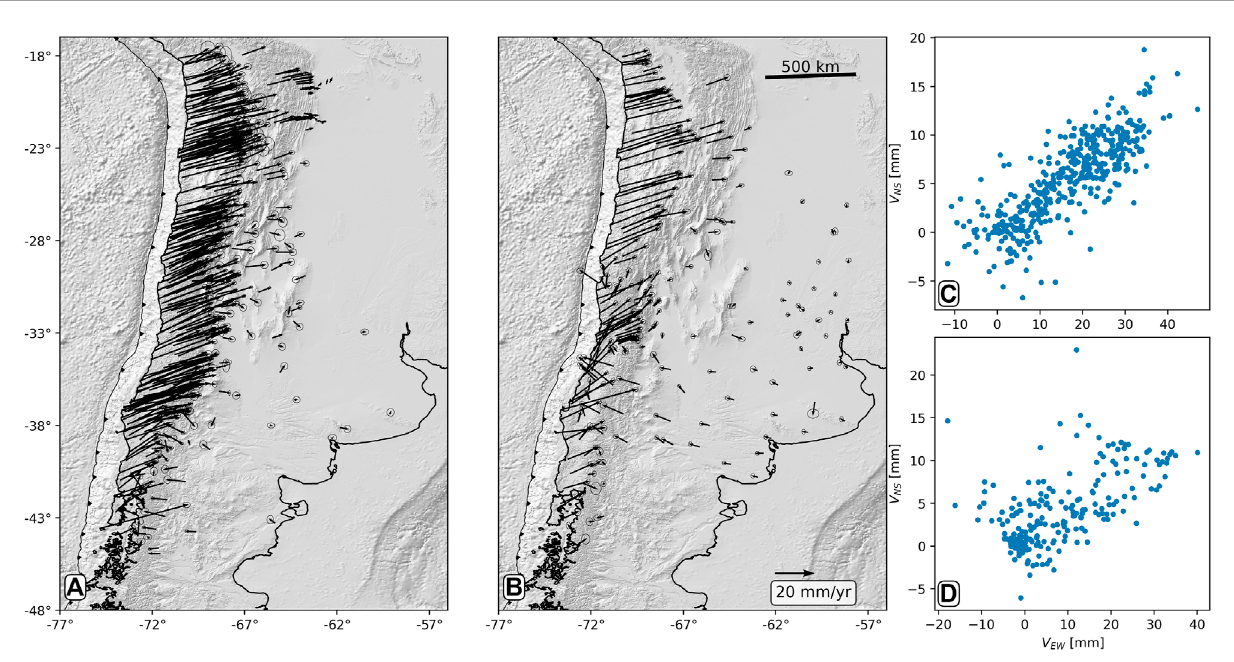
FIGURE 2 Study zone map and the GNSS interseismic velocities used in this study. (A,C) show pre-2014 velocities, and (B,D) show 2018–2021 velocities.